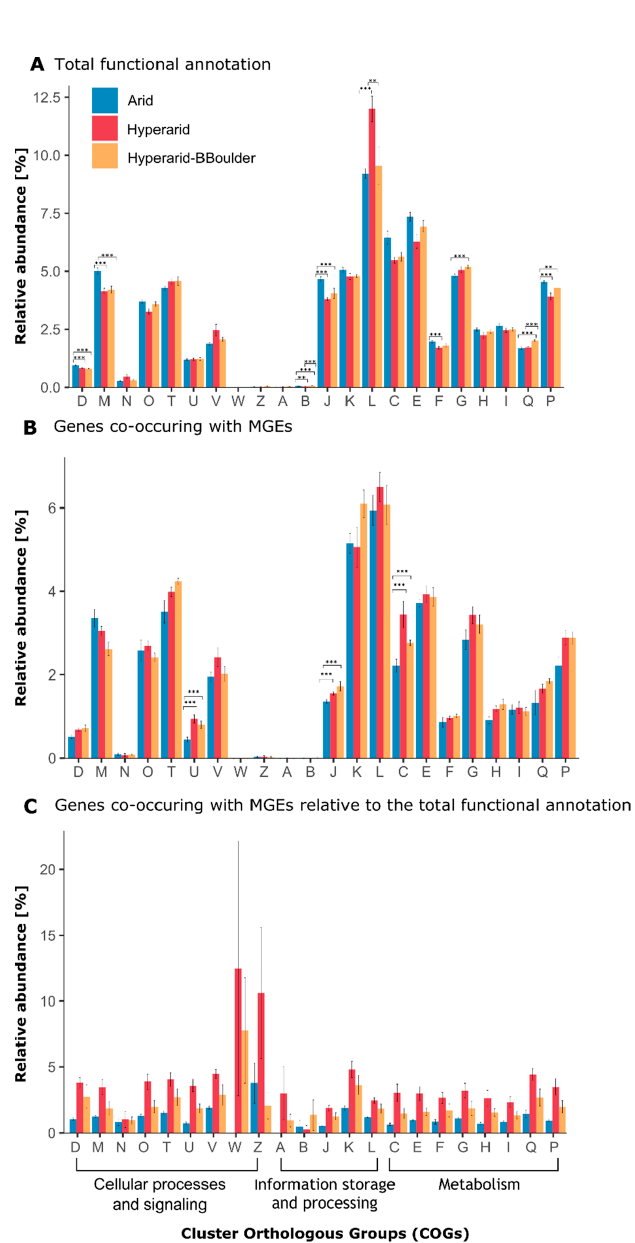
Figure 1. Abundance of Cluster orthologous group (COG) categories found at Arid, Hyperarid and Hyperarid-BBoulder sites. ( A ) the total functional potential, ( B ) only the genes co-occurring with MGEs and ( C ) proportion of genes co-occurring with MGEs relative to the total amount of genes per category. D: Cell cycle control, cell division, chromosome partitioning, M: Cell wall/membrane/envelope biogenesis, N: Cell motility, O: Post-translational modification, protein turnover and chaperones, T: Signal transduction mechanisms, U: Intracellular trafficking, secretion and vesicular transport, V: Defence mechanisms, W: Extracellular structures, Z: Cytoskeleton, A: RNA processing and modification, B: Chromatin structure and dynamics, J: Translation, ribosomal structure and biogenesis, K: Transcription, L: Replication, recombination and repair, C: Energy production and conversion, E: Amino acid transport and metabolism, F Nucleotide transport and metabolism, G : Carbohydrate transport and metabolism, H : Coenzyme transport and metabolism, I : Lipid transport and metabolism, Q : Secondary metabolites biosynthesis, transport and catabolism, P : Inorganic ion transport and metabolism. The standard error * < 0.05, ** < 0.005 and *** <